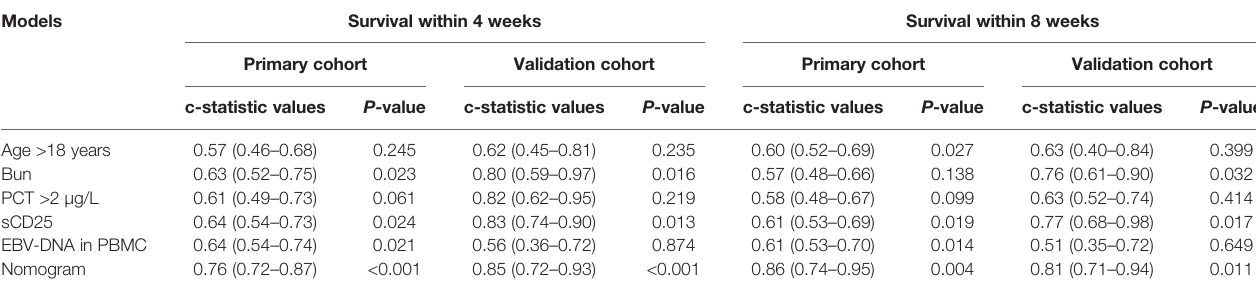
TABLE 3 | The predicting accuracies of different models for the death after receiving standard therapy. Models